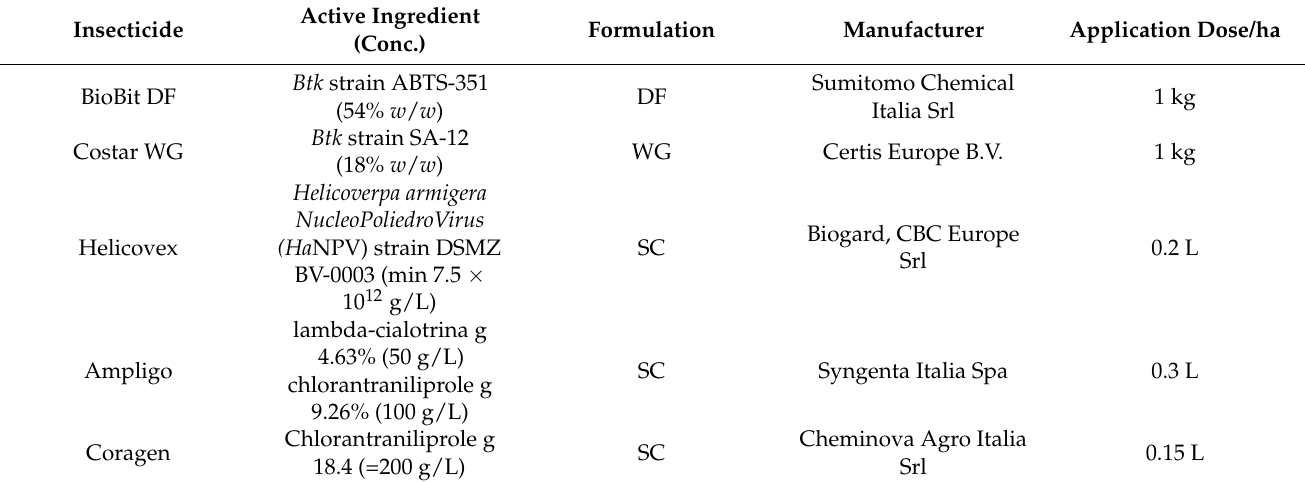
Table 1. Insecticidal products and active substances used in this